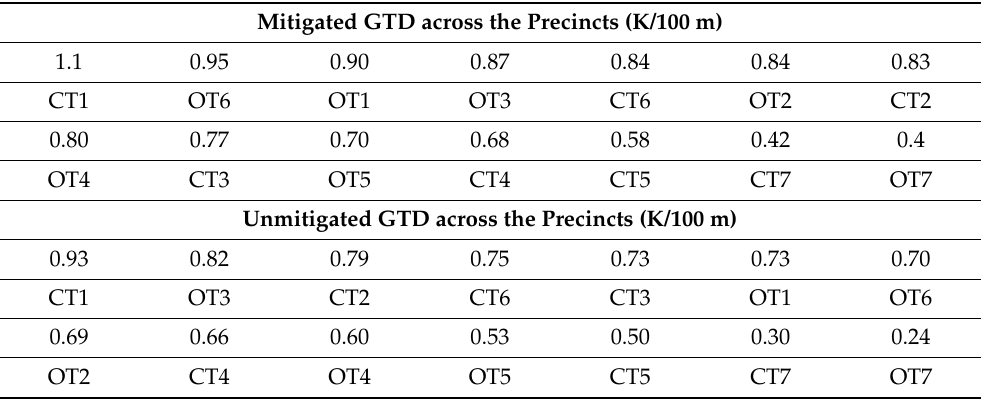
Figure 8. The GTD for OT3 precinct for both mitigated and unmitigated scenarios. Table 12. The Gradient Temperature Decrease at the wind flow direction for all